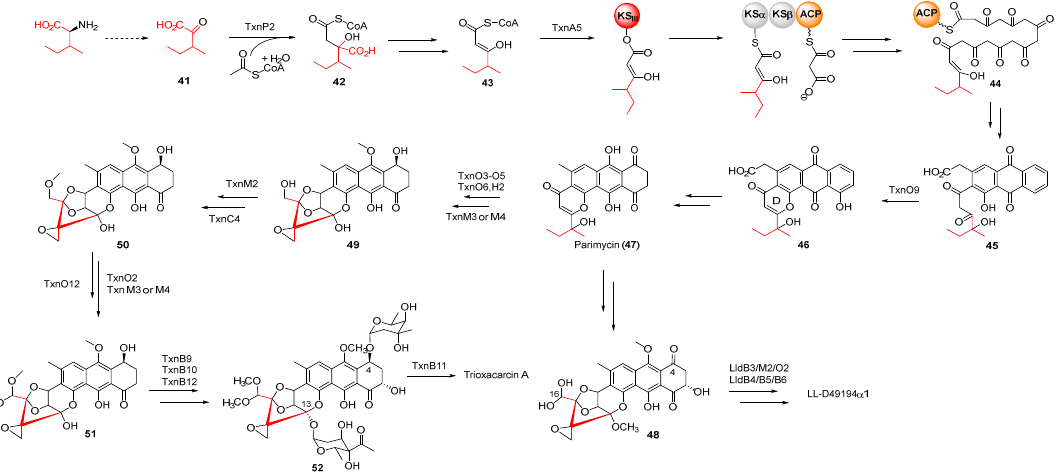
Figure 9. Proposed biosynthetic pathway of trioxacarcin A and LL-D49194 α 1. CLF, chain length factor.